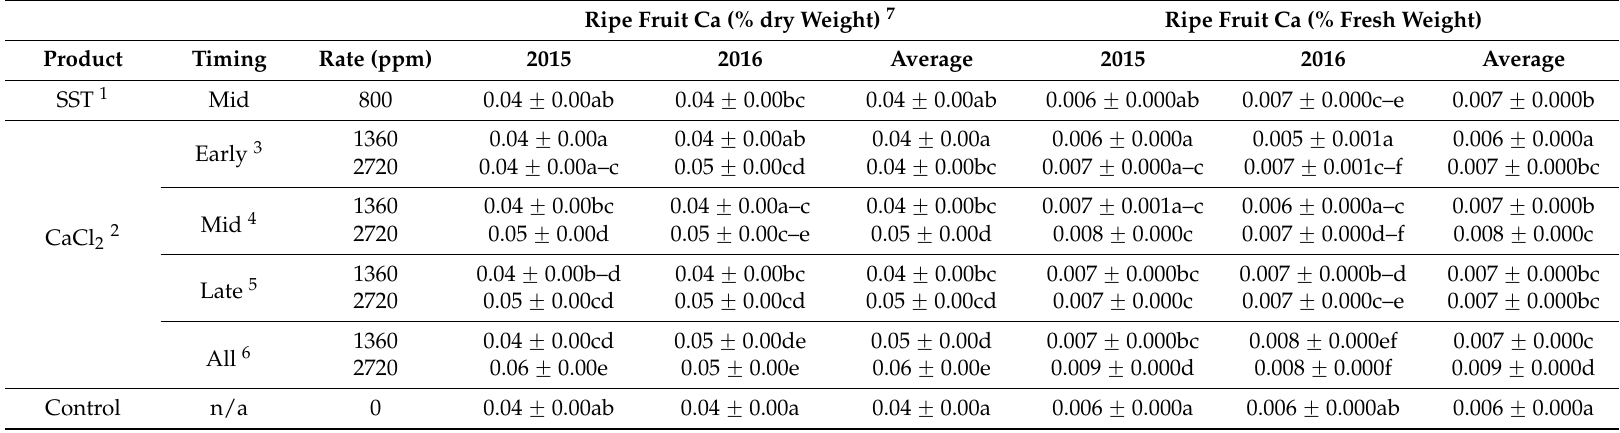
Table 5. Mean ˘ SE ripe fruit calcium concentration on a dry and fresh weight basis in ‘Draper’ highbush blueberry in response to foliar Ca products, application timings and rates across three sites in the Fraser Valley, British Columbia, Canada in 2015 and